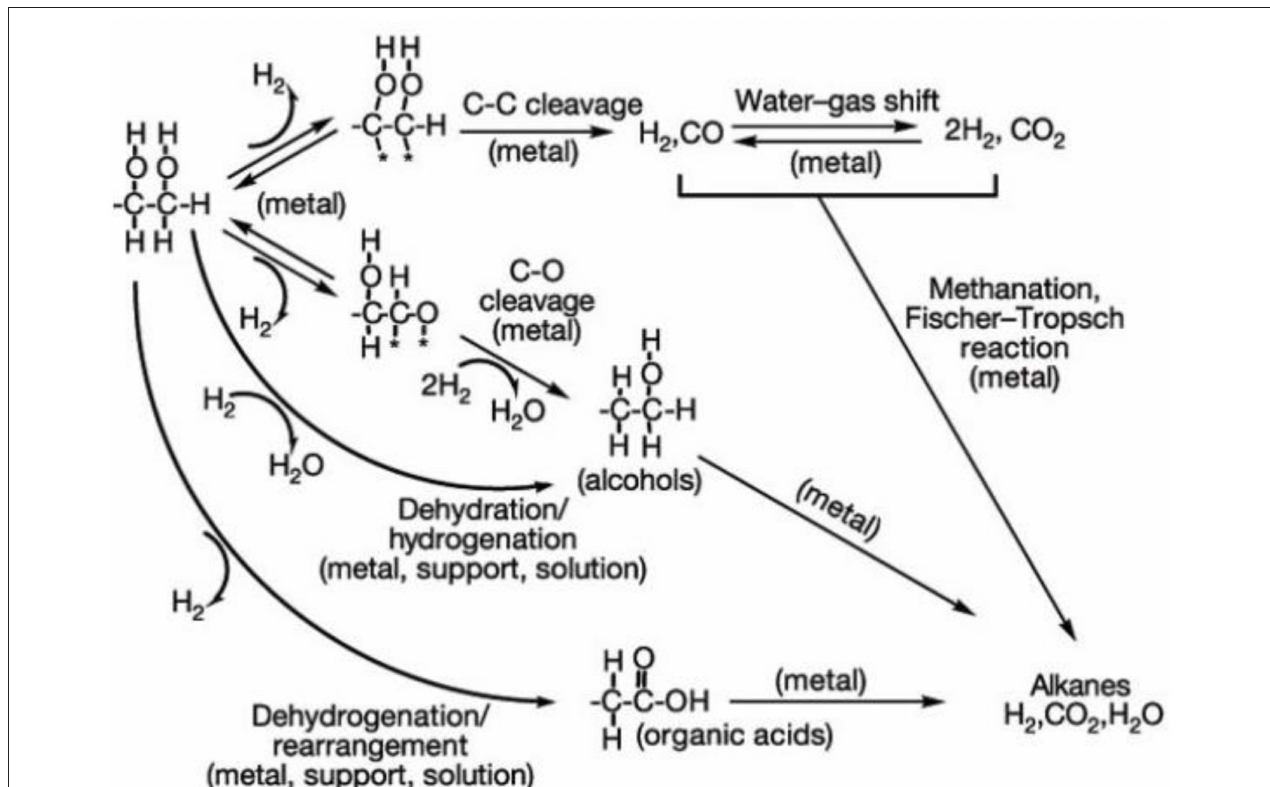
FIGURE 12 | Reaction paths for hydrogen production from compounds (adapted from Cortright et al.,